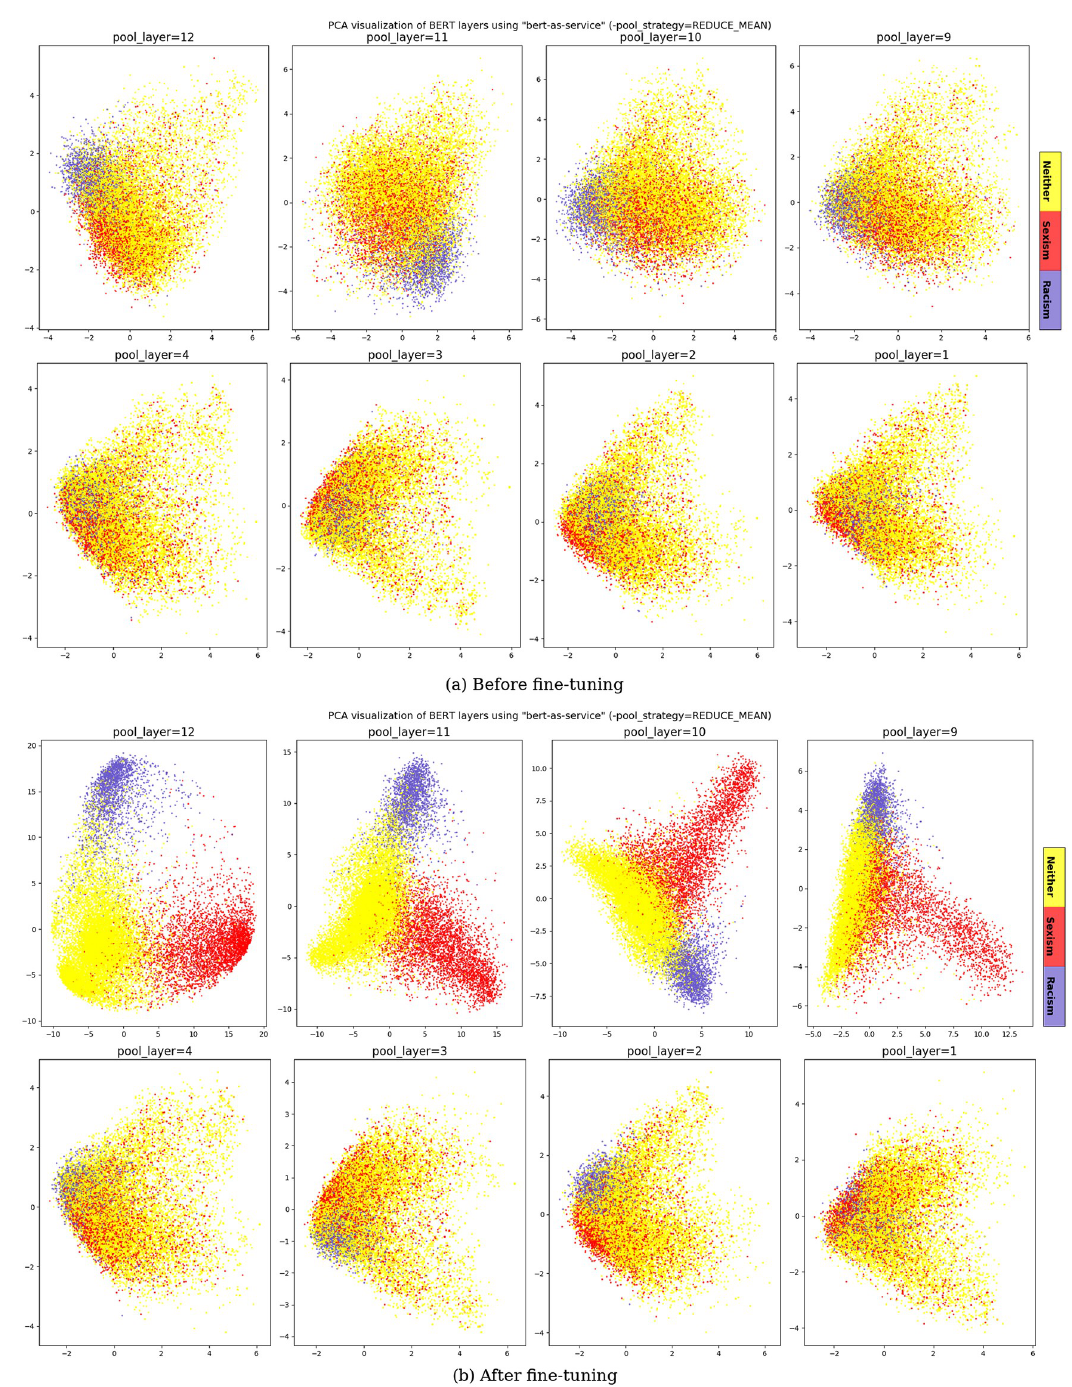
Fig 3. Waseem-samples’ embeddings analysis before and after fine-tuning. To investigate the impact of information included in different layers of BERT, sentence embeddings are extracted from all the layers of the pre-trained BERT model fine-tuning, using the bert-as-service tool. Embedding vectors of size 768 are visualized to a two-dimensional visualization of the space of all Waseem- dataset samples using PCA method. For sake of clarity, we just include visualization of the first 4 layers (1-4), which are close to the training output, and the last 4 layers (9-12), which are close to the word embedding, of the pre-trained BERT model before and after fine-tuning.